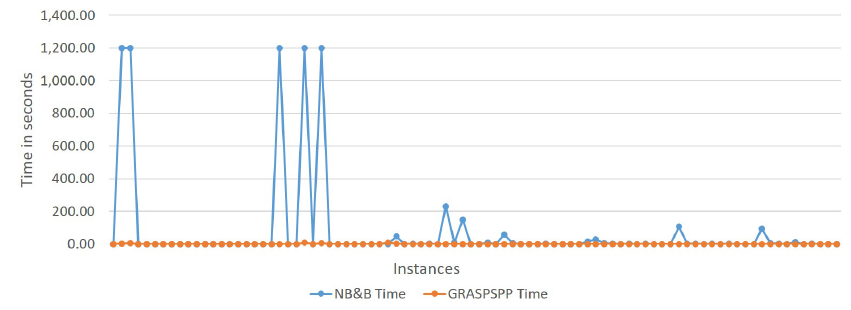
Figure 13. Time comparison between GRASPSPP and